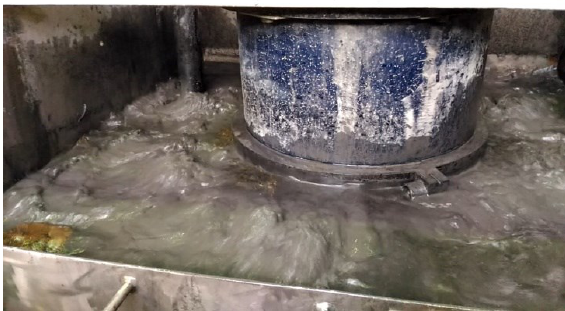
Figure 9. Developed technology of coal ash complex enrichment.